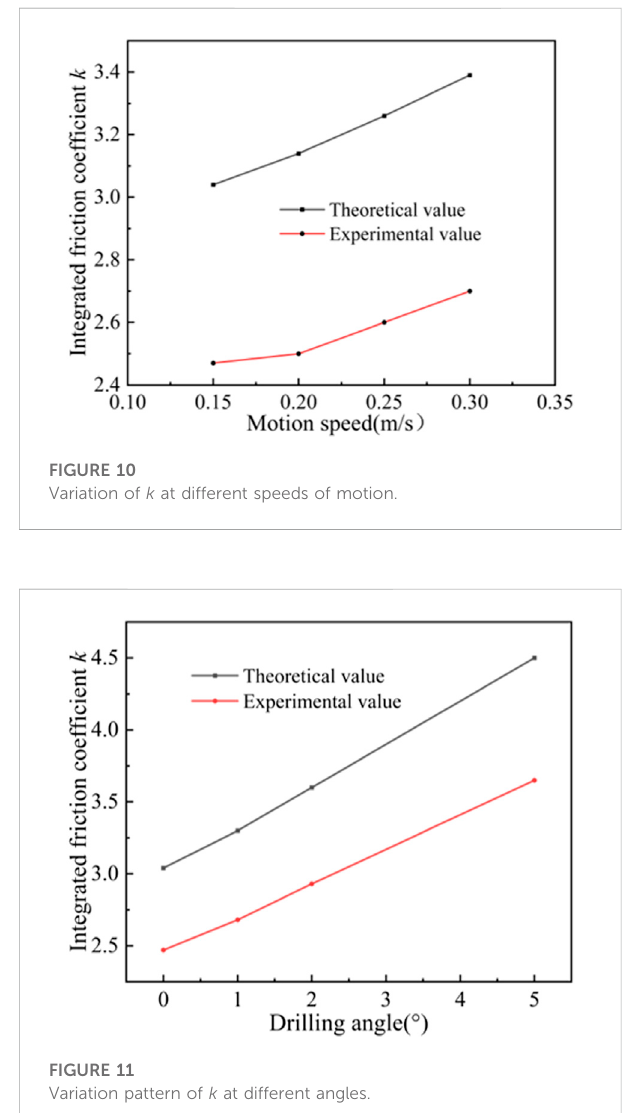
Figure 10 and Figure 11. The theoretical value of integrated friction coef fi cient k is larger than the experimental value. When the system pressure is 10 MPa, 15 MPa, 20 MPa and 25 MPa, the theoretical values of integrated friction coef fi cient are 3.04, 3.35, 3.6 and